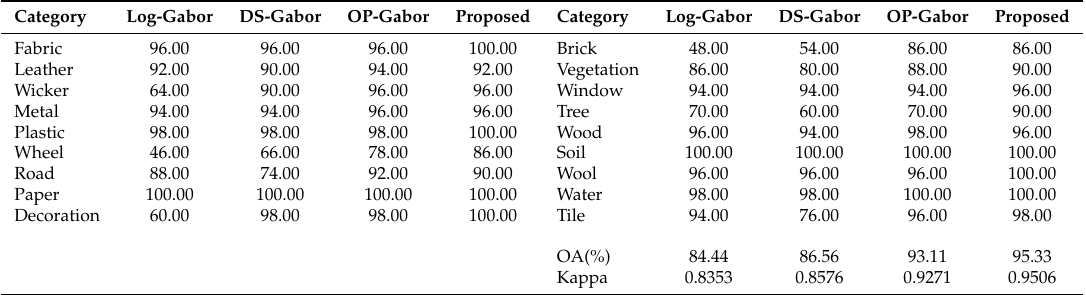
Table 3. Overall classification accuracy and Kappa coefficient for CGT database.